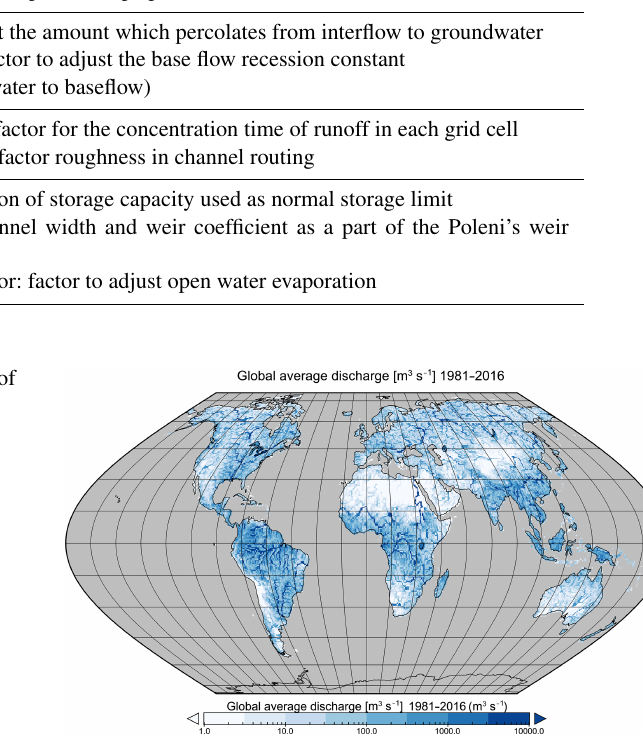
Figure 2. Average global discharge (in m 3 s − 1 ,